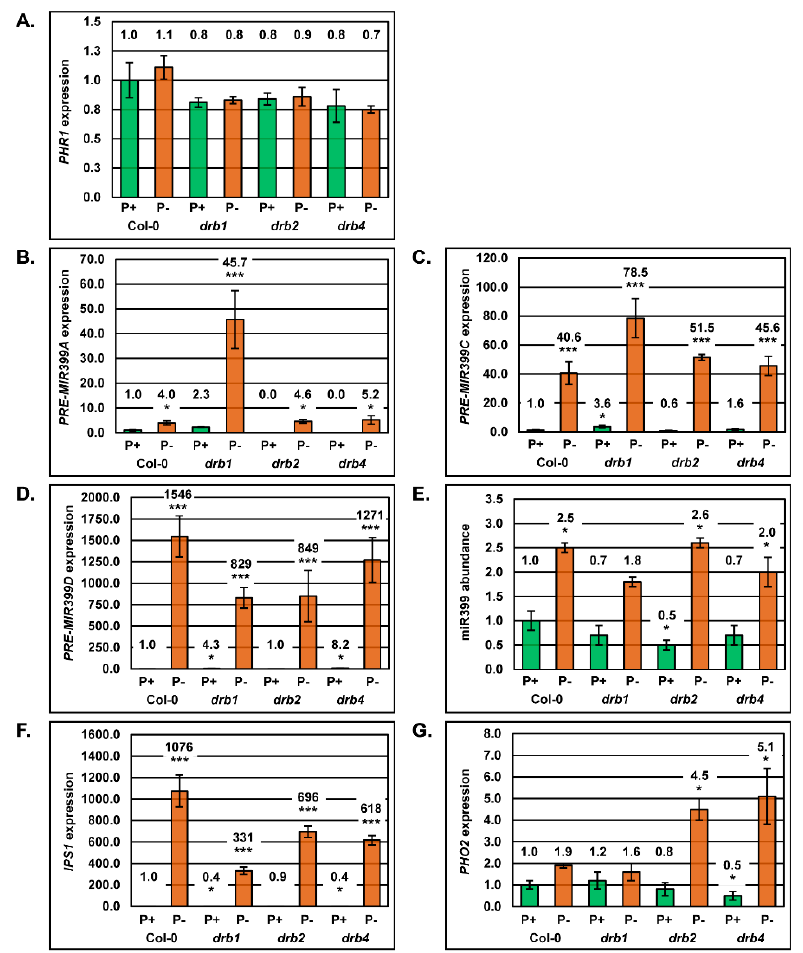
Figure 4. Molecular profiling of the miR399/ PHO2 expression module in the root system of non-stressed and PO 4 -stressed Col-0, drb1 , drb2 and drb4 plants. ( A ) RT-qPCR assessment of the expression of the PO 4 responsive transcription factor PHR1 in the roots of non-stressed and PO 4 -stressed Col-0, drb1 , drb2 and drb4 plants. ( B–D ) RT-qPCR profiling of miR399 precursor transcript abundance in the